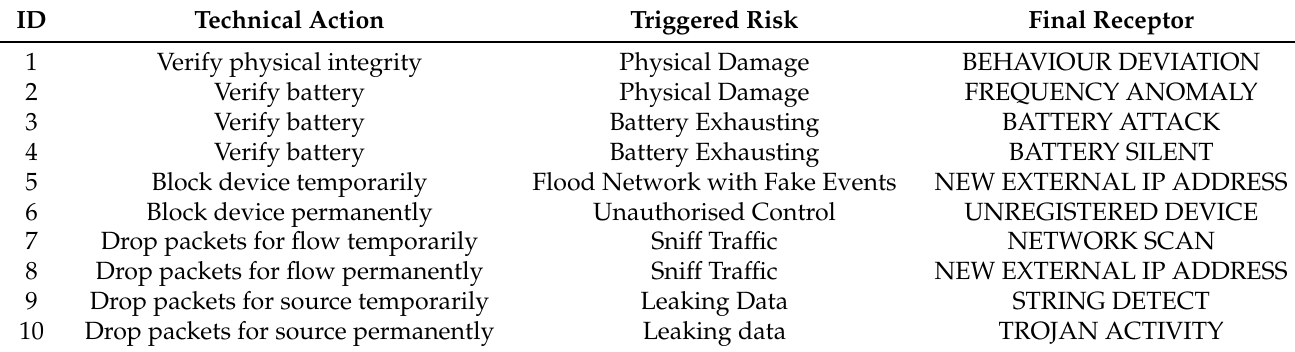
Table 4. Automatable action